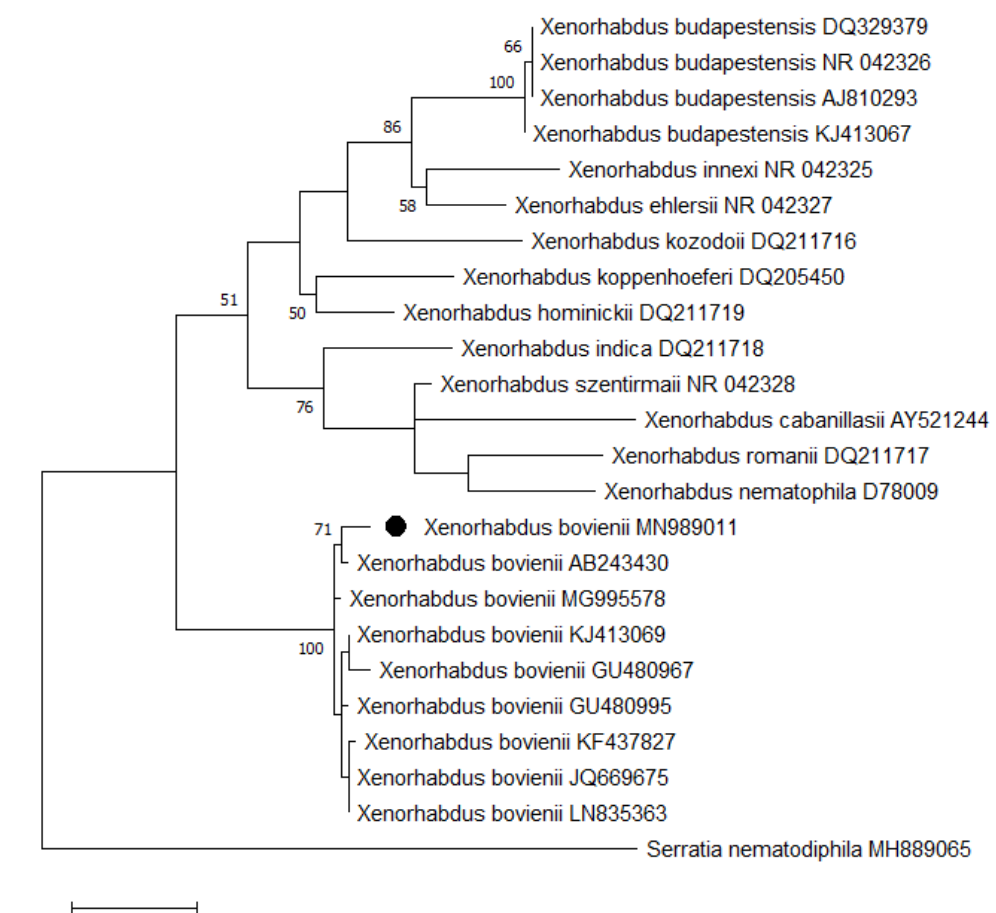
Figure 2. Phylogenetic relationship of representative Xenorhabdus bacteria associated with steinernematids based on the 16S rRNA gene sequences. The tree was reconstructed by the maximum likelihood method. Xenorhabdus bovienii isolated from S. litorale CTP19-1 is shown as labeled. The 16S rRNA gene sequences of Serratia nematodiphila (MH889065) was used as the outgroup species. The GenBank accession numbers are indicated after the name of bacterial isolates. Numbers more than 50% at branch-point indicate in percentage how often the corresponding cluster was found among the 1000 intermediate trees. The bar represents 0.02 substitutions per site.